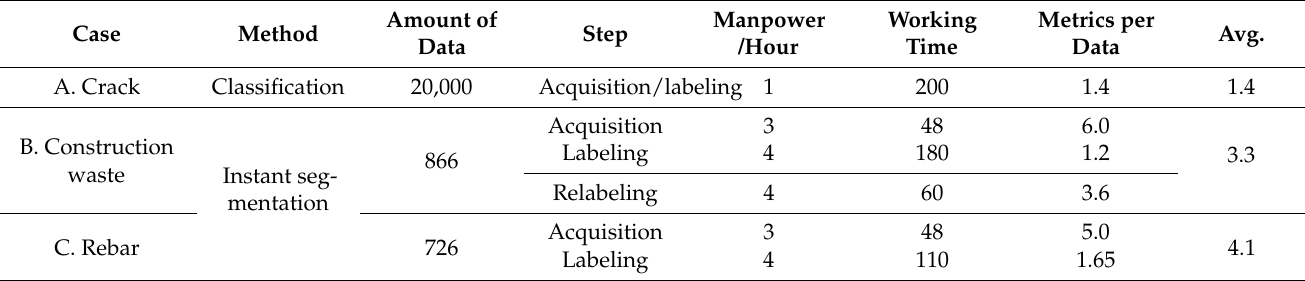
Table 4. ‘Work index’ on the basis of required manpower and hours depending on the AI R&D